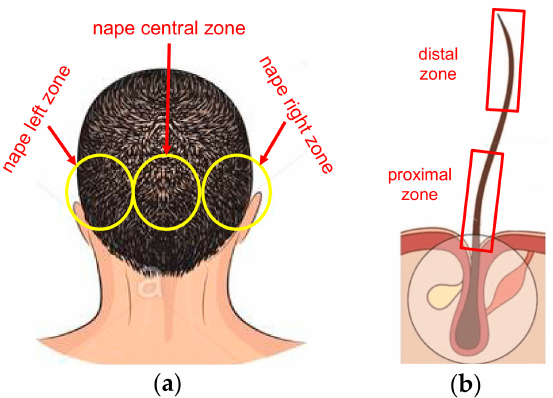
Figure 1. Scheme of the sampling area ( a ) and representation of the proximal and distal hair zones analyzed ( b